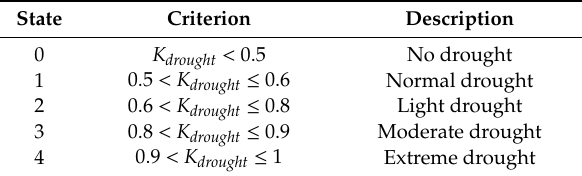
Table 3. Definition of the state of hydrological drought